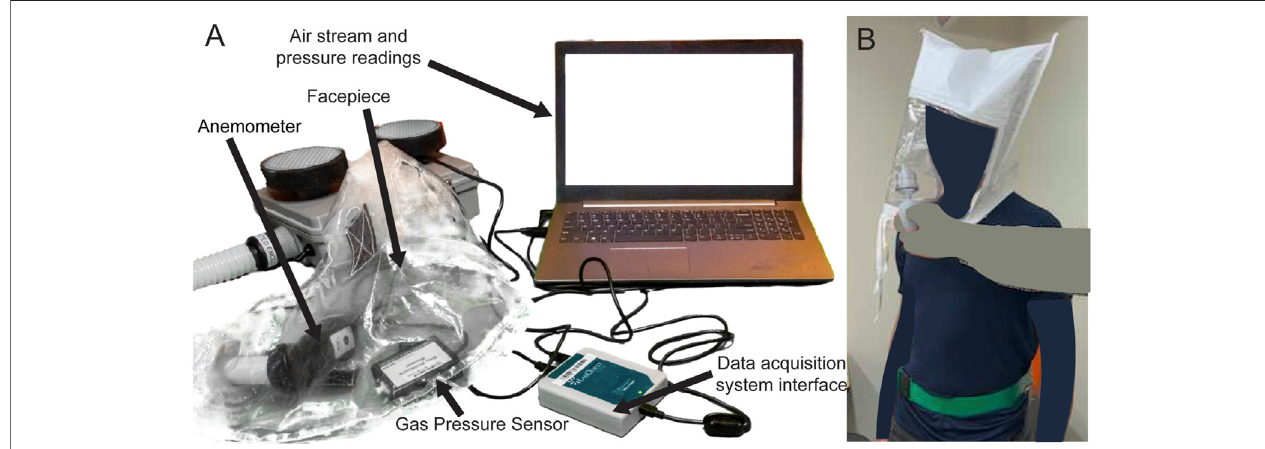
FIGURE 3 | (A) Test setup to measure fl ow rate and the positive pressure inside the facepiece, using Vernier Anemometer and Gas Pressure Sensor. PAPR facepiece contains anemometer and gas pressure sensor. Tape covers the neck opening of the facepiece for testing. (B) Bitrex Fit Test setup.